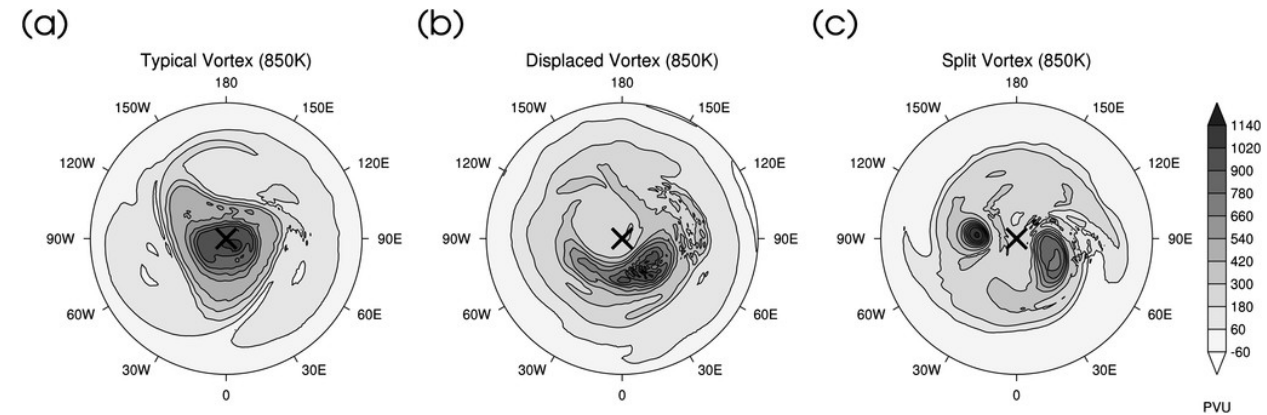
Figure 9. Daily averaged PV (10 − 6 m 2 s − 1 Kkg − 1 ) fields for three different states of the NH polar vortex on the 850K isentropic surface: (a) the stable state of the vortex, (b) a displaced vortex and (c) a vortex that has split into two daughter vortices. Black crosses mark the North Pole. Figure 1 from Mitchell et al. (2011). ©American Meteorological Society. Used with permission.